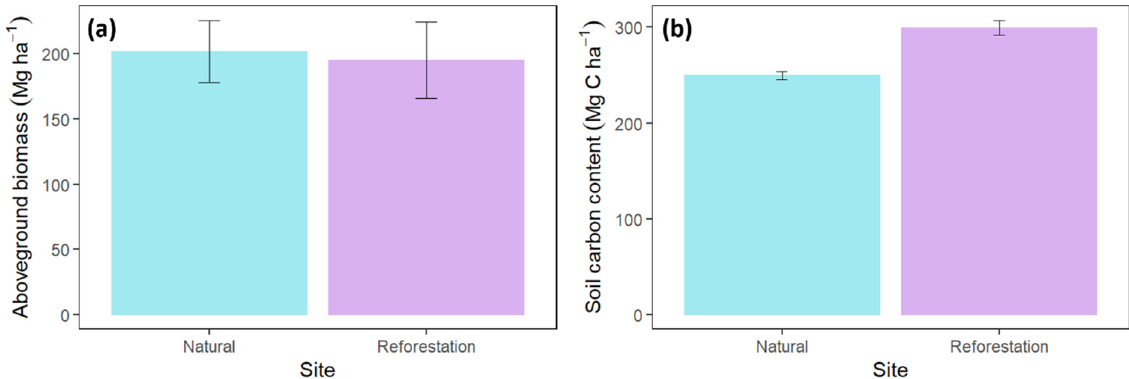
Figure 6. The total aboveground biomass (panel a ) and soil carbon content (panel b ) in the natural mangrove stand and refor- estation mangrove site in Zamboanga del Sur,